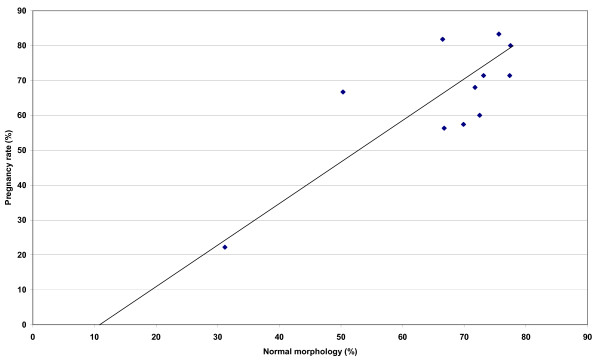
Relationship between normal morphology (%) and pregnancy rate (%) following artificial insemination with cooled, transported stallion spermatozoa derived from the ejaculates tested in this study (n = 41). The line of best fit for the data points is shown. Note: Statistics r = 0.789; P < 0.01.